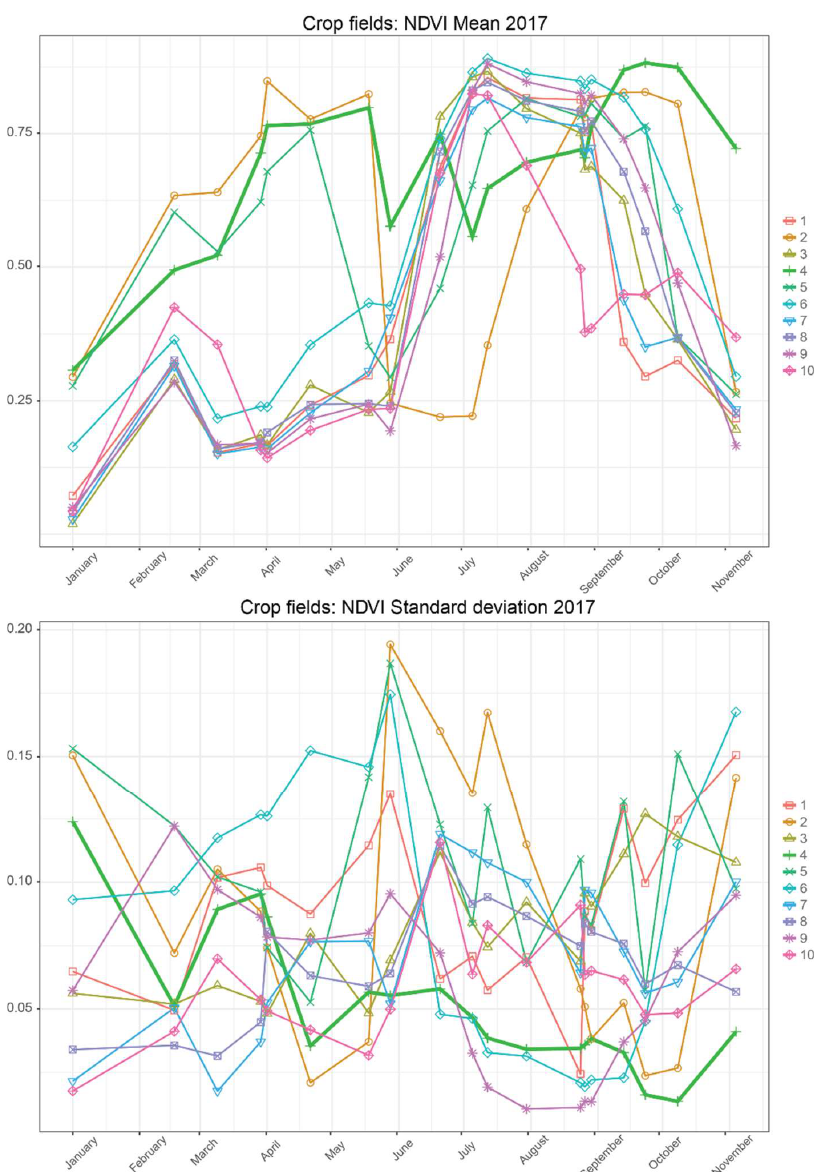
Figure 8 . Temporal graph (NDVI development curve) of the selected ten crop fields in Duplek area shows the trajectories of mean and standard deviation values. The irregular behavior of one crop field is highlighted as a thicker line (object 4).